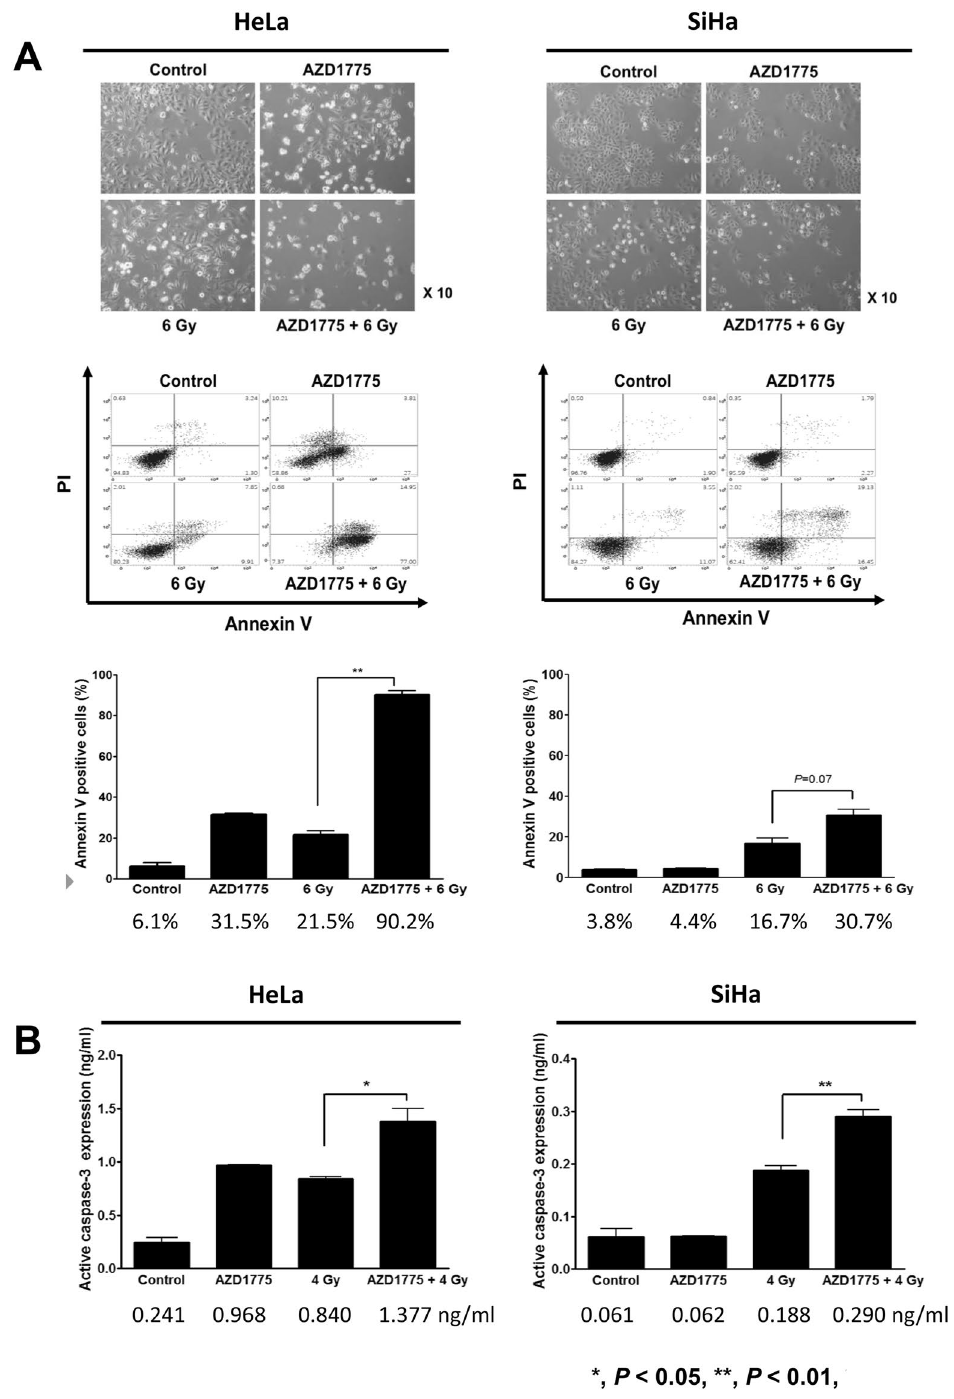
Figure 3. AZD1775 and IR enhanced apoptosis in HeLa and SiHa cells. Cells were treated with 100 nM AZD1775 1 h prior to IR (6 Gy). At 72 h after IR, light microscopy photographs were taken ( × 10) and annexin V was quantified by FACS analysis for each group ( A ). Apoptosis assay was performed by measuring active caspase-3 with ELISA. AZD1775 (100 nM) was added 1 h prior to IR (4 Gy) and active caspase-3 was measured 48 h after IR ( B ). All experiments were repeated three times. The error bar represents standard error of the mean